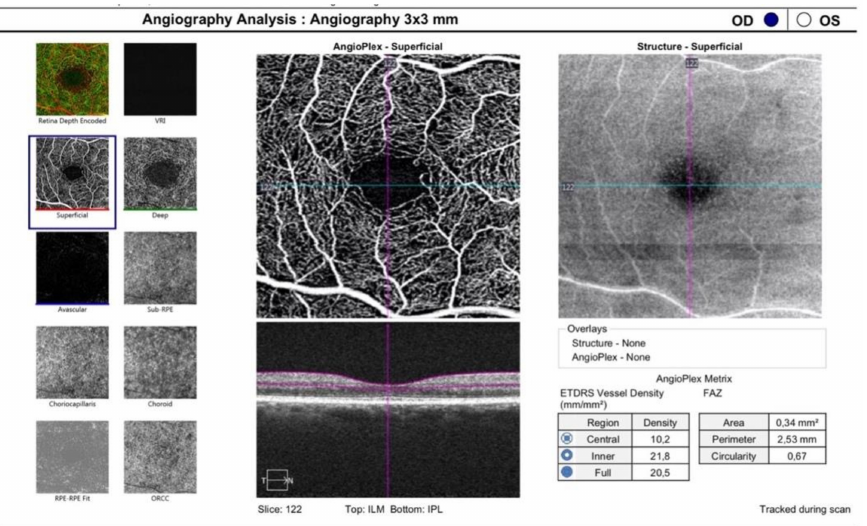
Figure 3. A 3 × 3 mm OCTA scan focused on the fovea. SCP, DCP and CC could be analyzed.